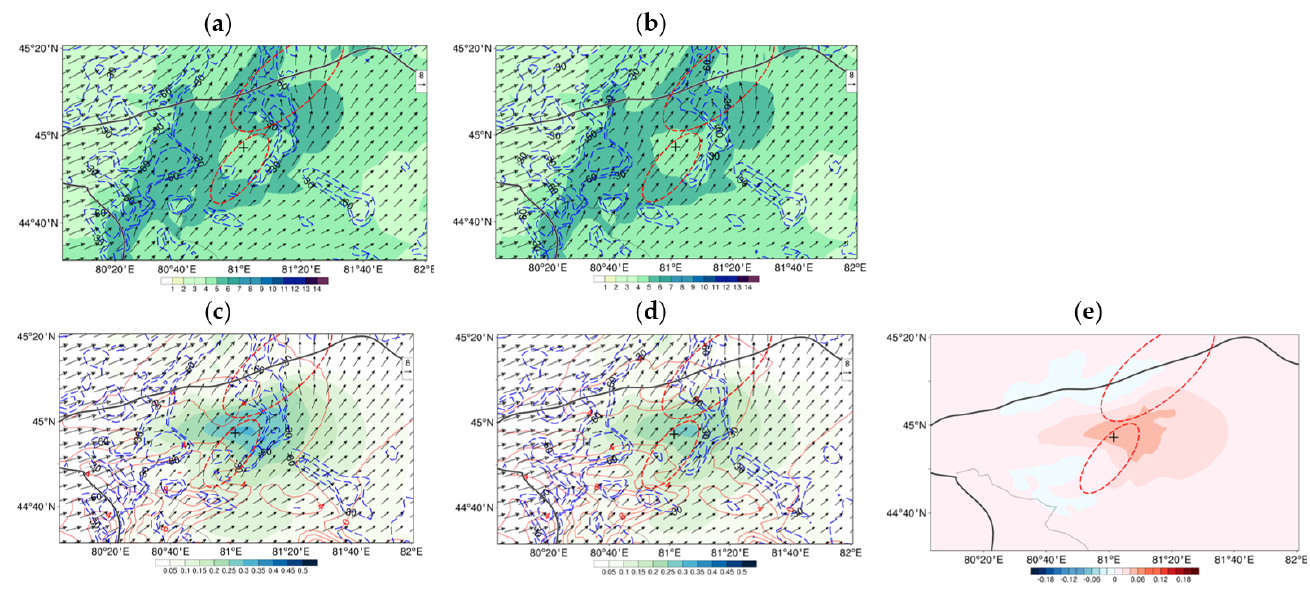
lines indicate the increment of temperature (unit 0.001 °C). The dashed blue lines indicate the anal- ysis of negative divergence (unit 1/s). The ellipse of dashed red lines indicates the main areal cover- age of precipitation which is the same below.